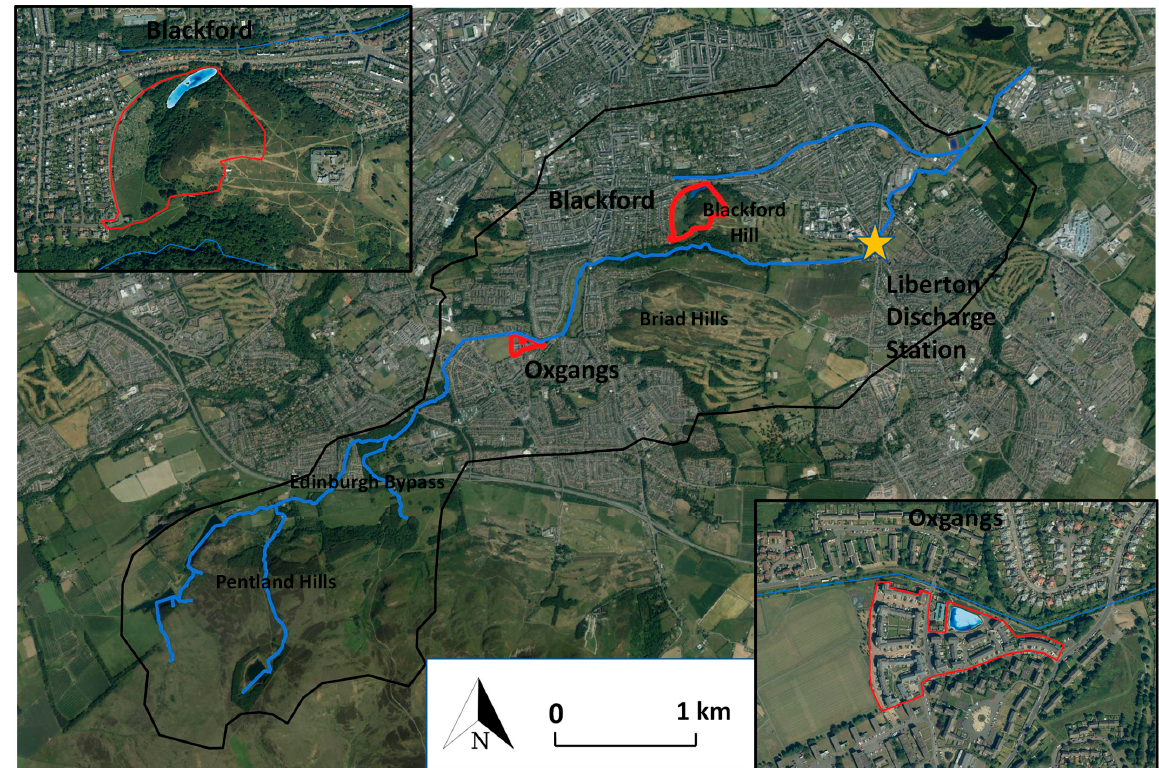
Figure 1. The Braid Burn catchment, showing the location of the Liberton Discharge station, the existing Blackford and Oxgangs Ponds and their catchment boundaries.